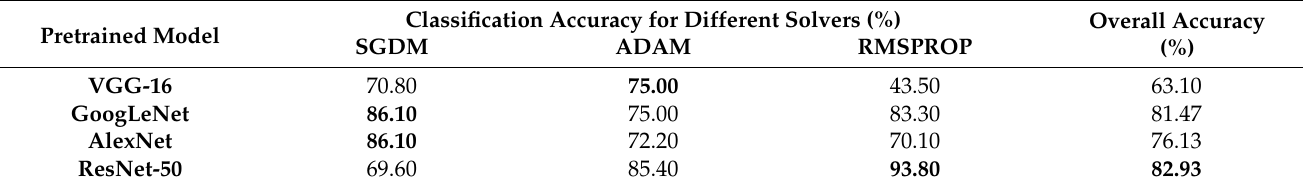
Table 4. Performance of pretrained networks for different